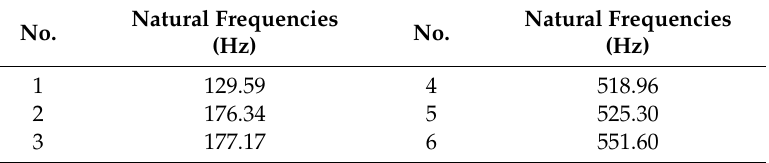
Table 2. The first six natural frequencies.